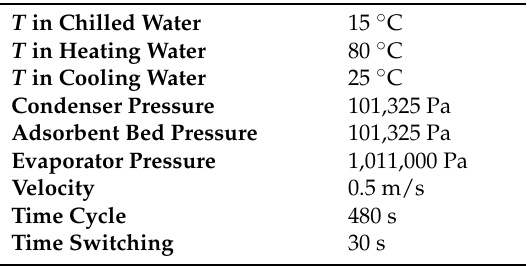
Table 2. Parameters of the standard operating conditions employed in simulation code.